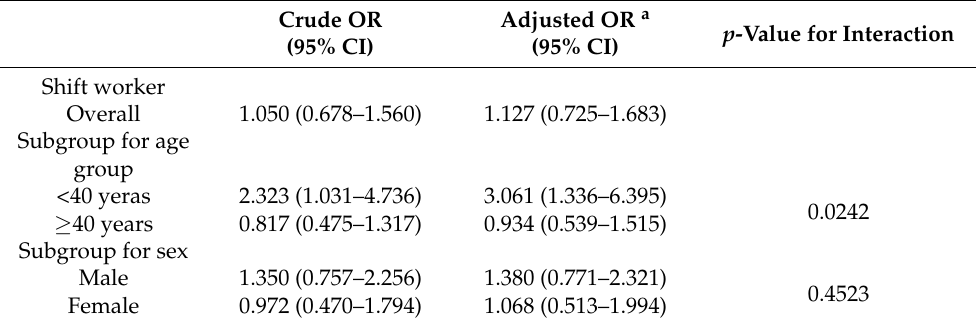
Table A2. Odds ratio (OR) of dry eye disease according to shift work, by age group and sex including 65 years of age or older. Crude OR (95%